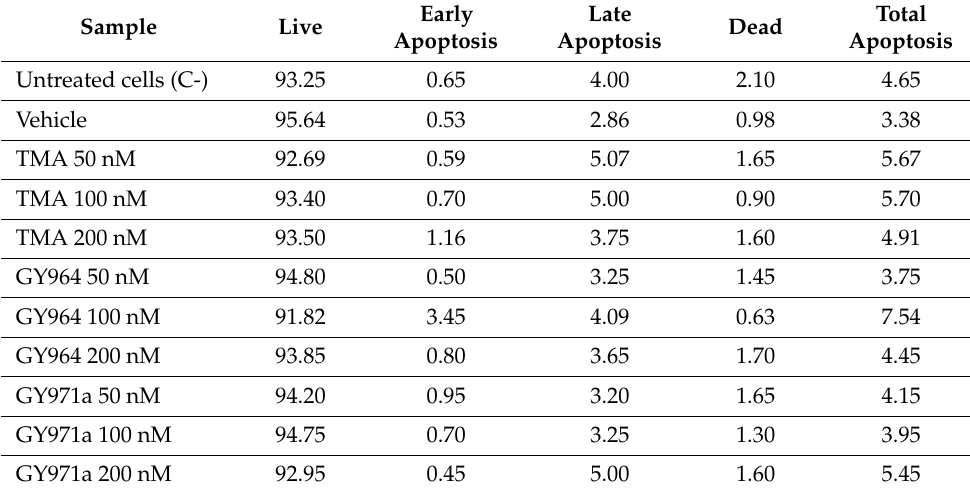
Table 3. Pro-apoptotic activity (%) of TMA and GY964 (4-PhDMA), dissolved in DMSO (Vehicle), and GY971a (pANDMA), dissolved in water, on CFBE41o- cells. Early Sample Live